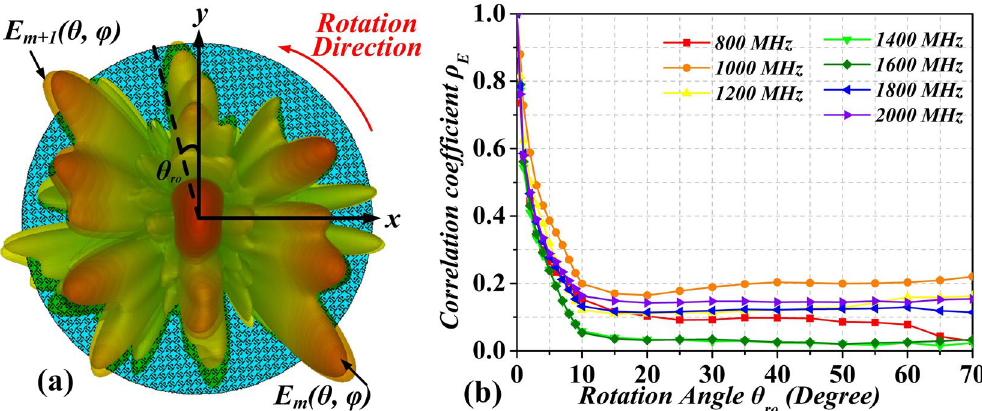
Figure 12. The far-field patterns of the metasurface in different rotation angle θ ro ( a ), and the correlation coefficient ρ E at different operating frequencies of the